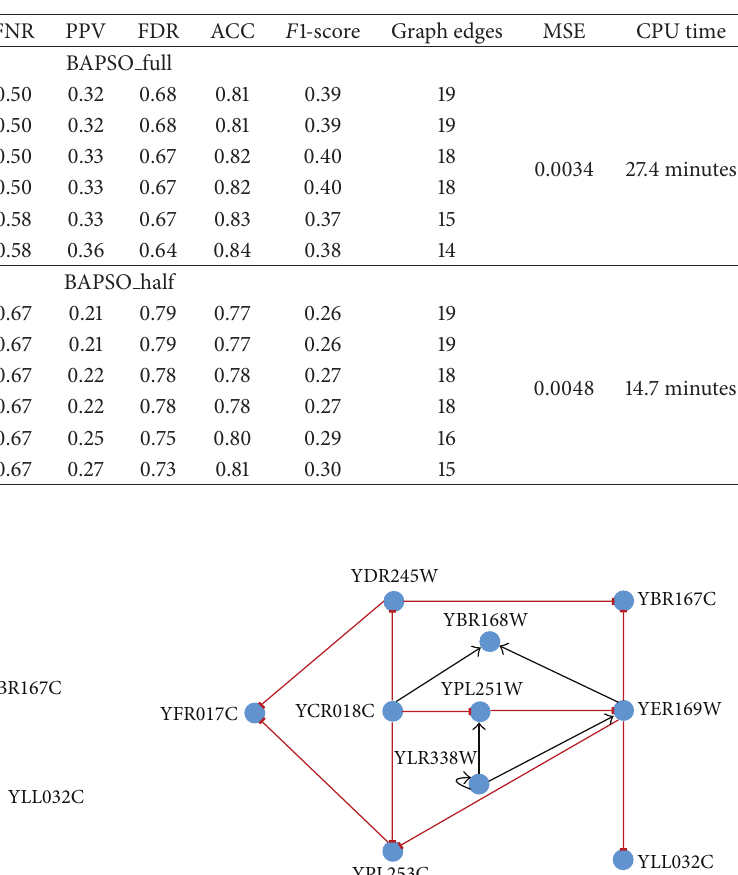
Table5:ResultsfortheyeastdatasetextractedfromGNWwith50timepointsand25timepointsrepresentedasBAPSO fullandBAPSO half.